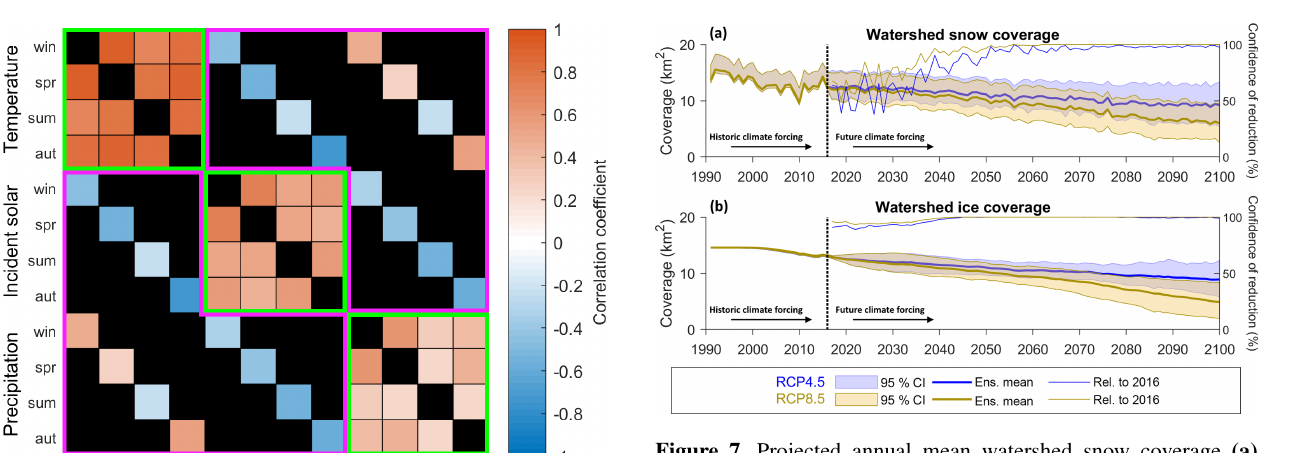
Figure 7. Projected annual mean watershed snow coverage (a) and ice coverage (b) including the projection confidence intervals (bands) and ensemble mean projections (thick solid lines) for the RCP4.5 (blue) and RCP8.5 (yellow) projections. Also shown are projection confidence levels for a reduction in coverage relative to 2016 (thin solid lines, right-hand